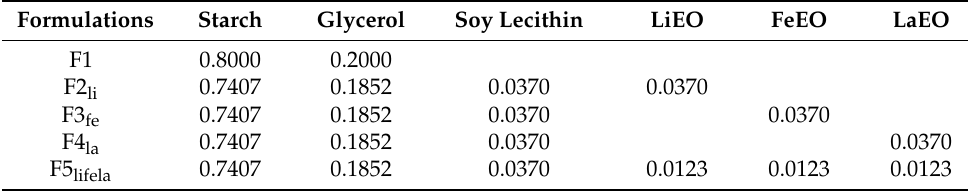
Table 1. Studied formulations expressed in mass fraction. Formulations Starch